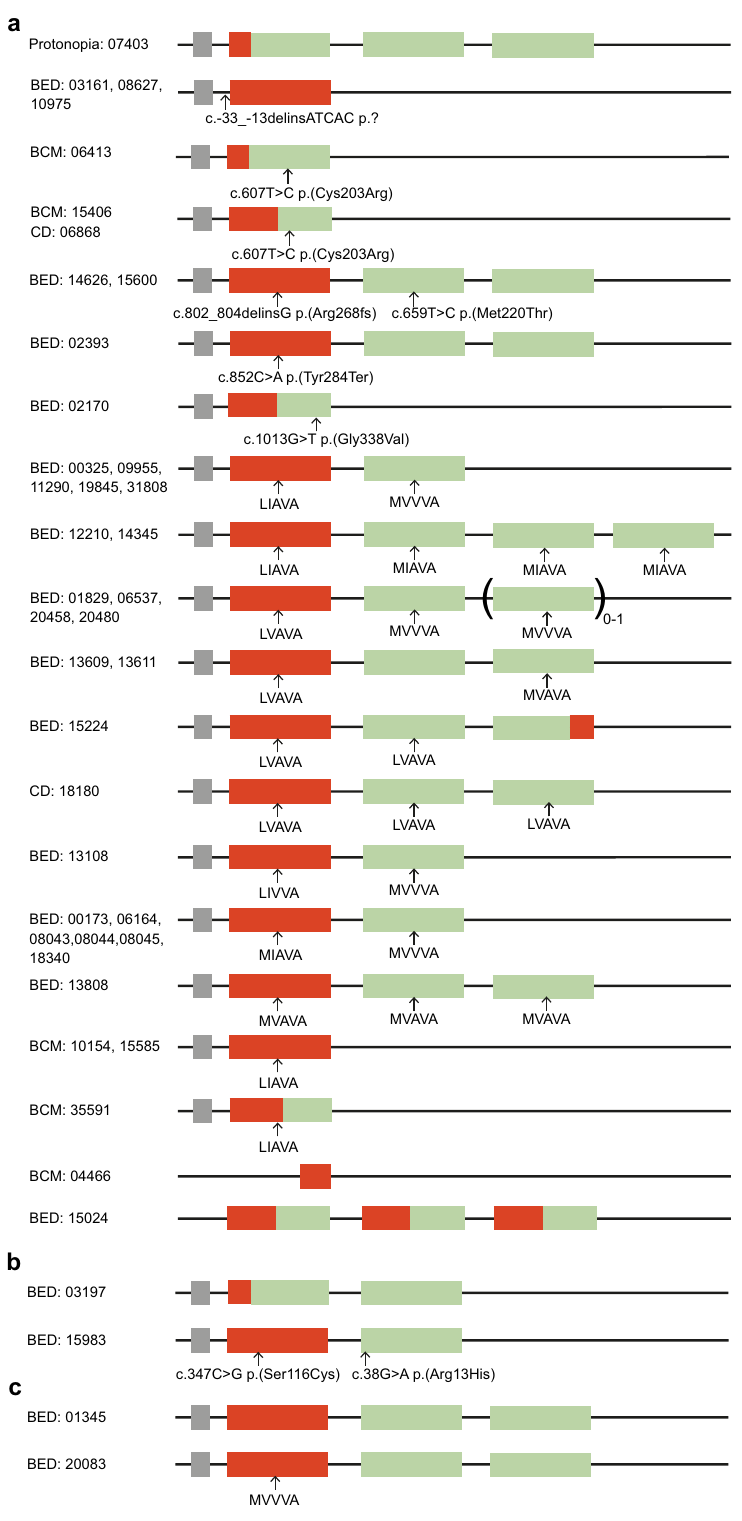
Fig. 4 Schematic overview of the alleles detected in the 43 clinical samples in whom genetic analysis of the OPN1LW / OPN1MW gene cluster was performed to determine the genetic cause of their visual impairment. a Causative alleles detected in 39 patients with protanopia, BED, BCM, and/or cone dystrophy. b Alleles detected in two samples of which it is unknown whether they are causal. c Two samples in which detected alleles are not causal for the inherited visual impairment of the